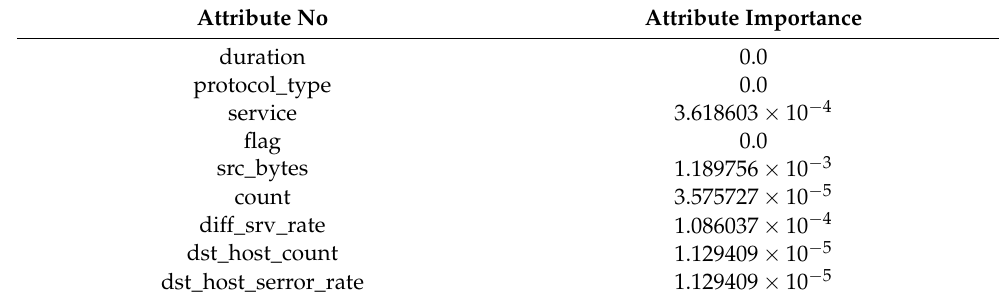
Table 3. Attribute importance.